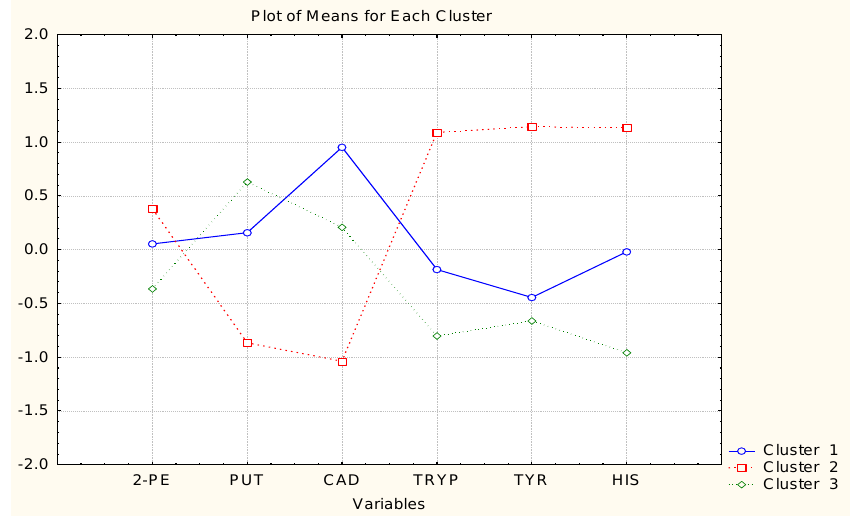
Figure 4. Averages of variables for each cluster (Wine A).